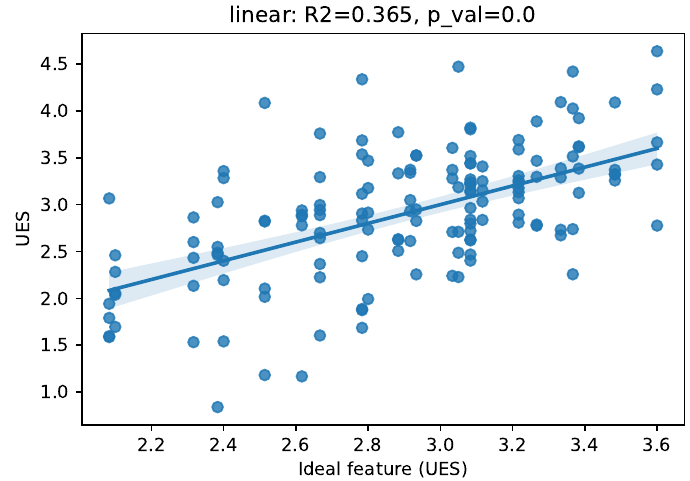
Figure 4. Scatter plot and corresponding linear regression plot for the optimal video feature against the overall User Engagement Score (UES). Note that the x -axis (abscissa) relates to categorical variable of Video ID; the assigned numerical values are equal to corresponding mean engagement